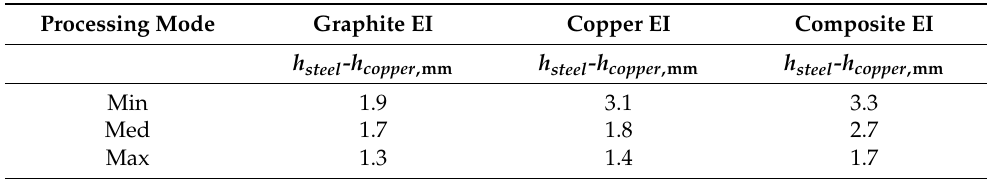
Table 3. The calculated values of the unevenness of material removal during processing of steel– copper bimetallic material,